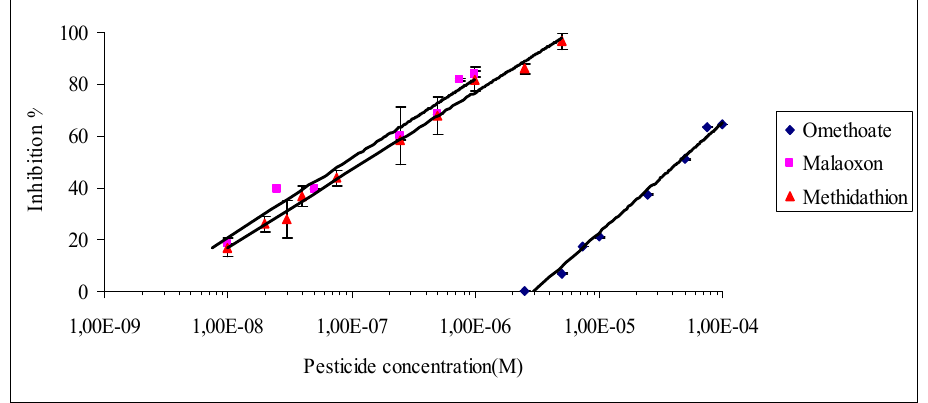
Figure 3. Inhibition effect of omethoate, methidathion and malaoxon on the